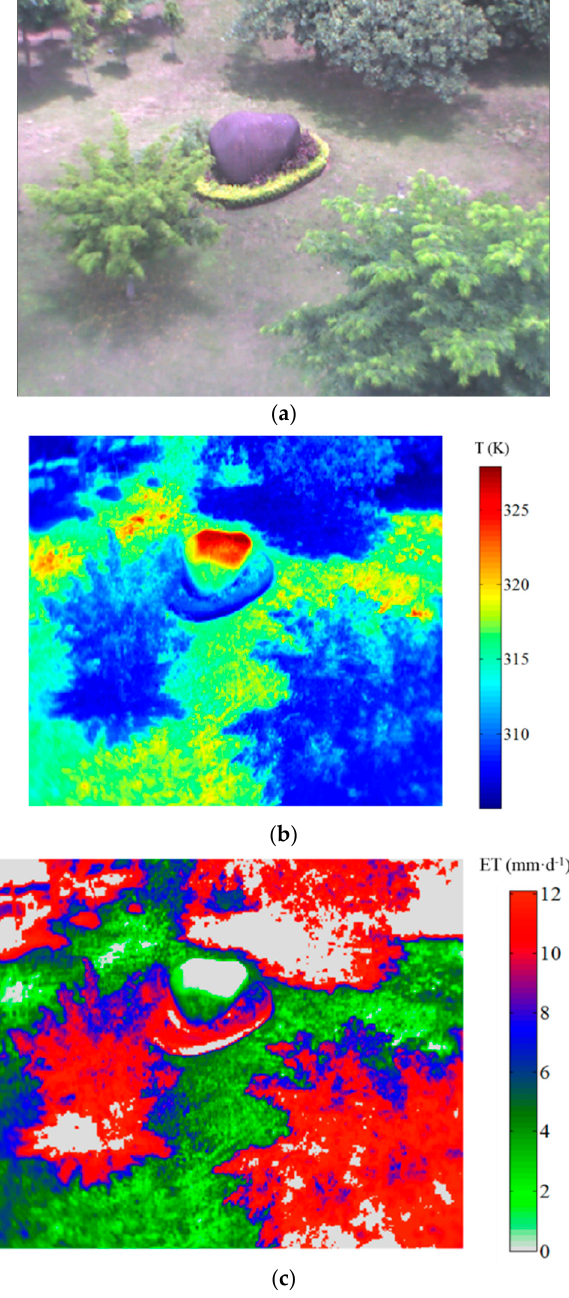
Figure 6. Visible light image ( a ), temperature image ( b ), and ET of a lawn ( c ) at 12:00 on 15 July 2014. ET was estimated by infrared RS + 3T model method. Images were taken almost vertically from a tower approximately 50 m high.